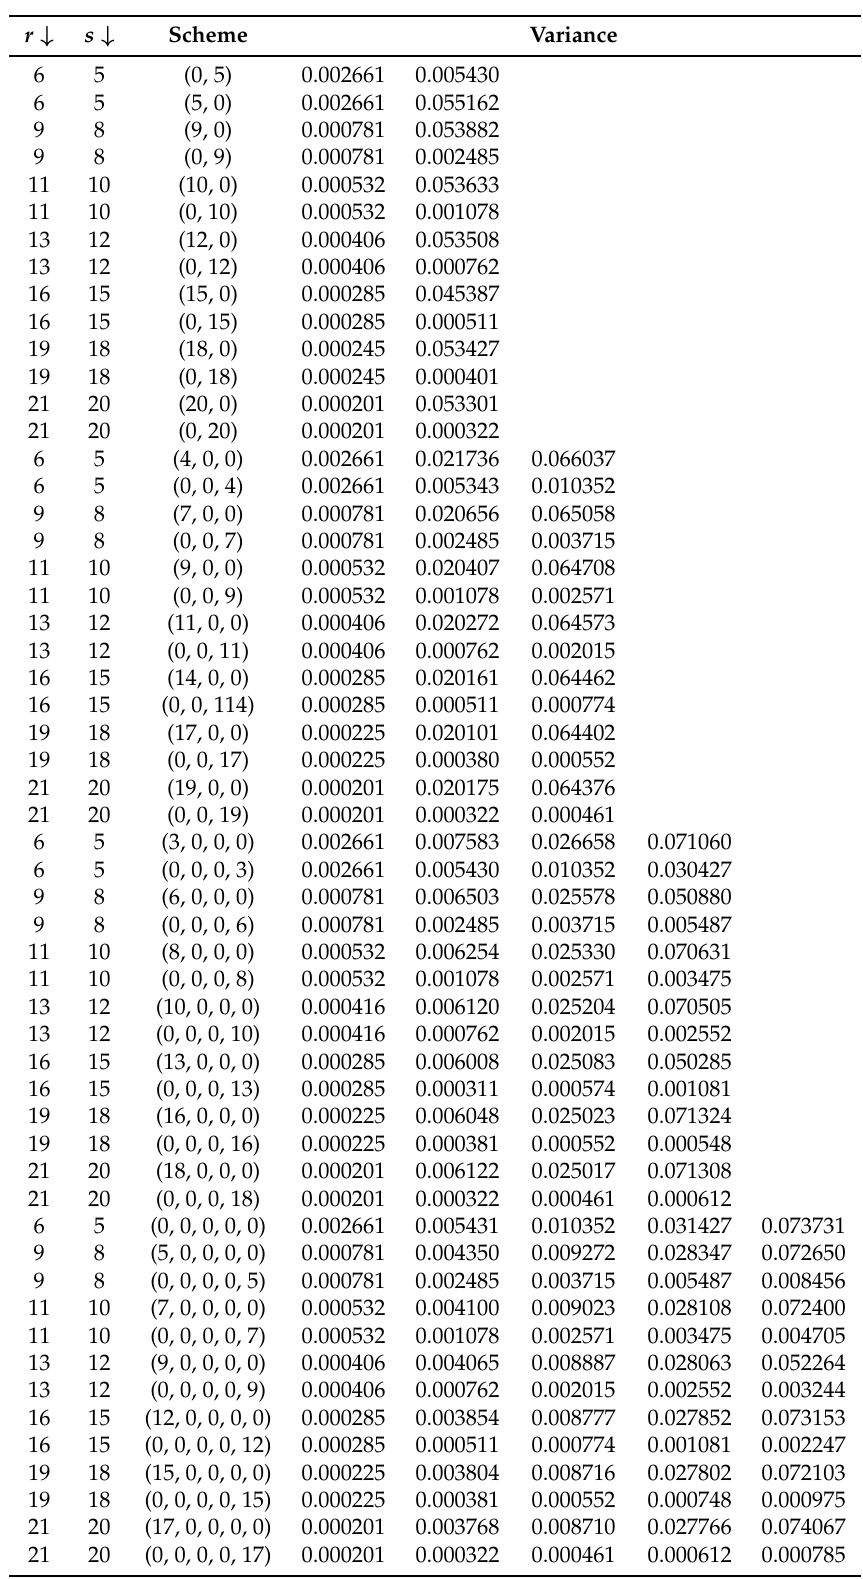
Table 4. Variances of two parameter RK distribution for different values of parameters, e.g., µ = 3 and λ =